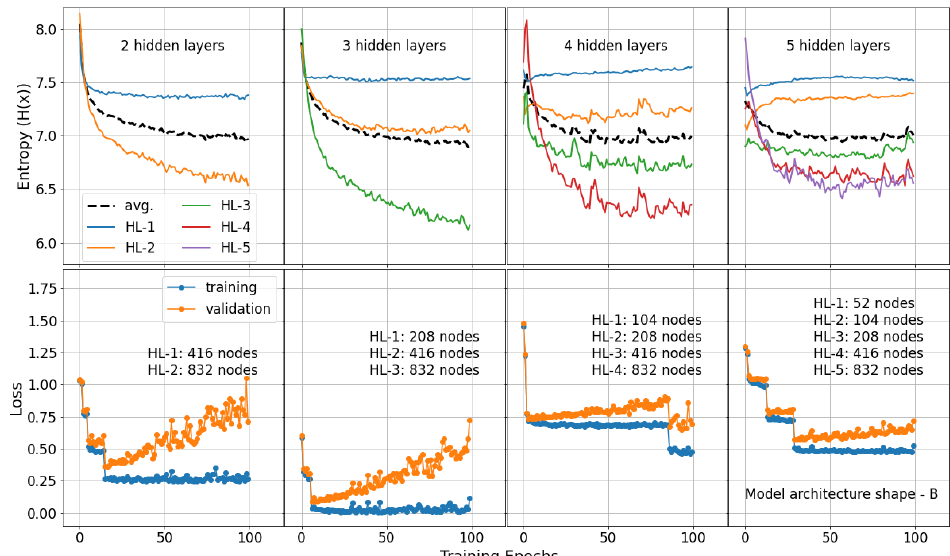
Figure 7. First row of figures show the entropy profile of four different shallow neural networks. Second row shows the corresponding training and validation losses. Number of hidden layers were changed from two to five. The number of nodes in each hidden layer (HL) of these models are printed in each sub-figure of second raw. Note that the black curves in the first row of figures show the average (avg.) entropy of each model. These models were trained using 60,000 MNIST-digits images with 33% validation split. NLLLoss [41] was used as the loss function and the Adam optimizer [42] with learning rate 0.001 was used for the model